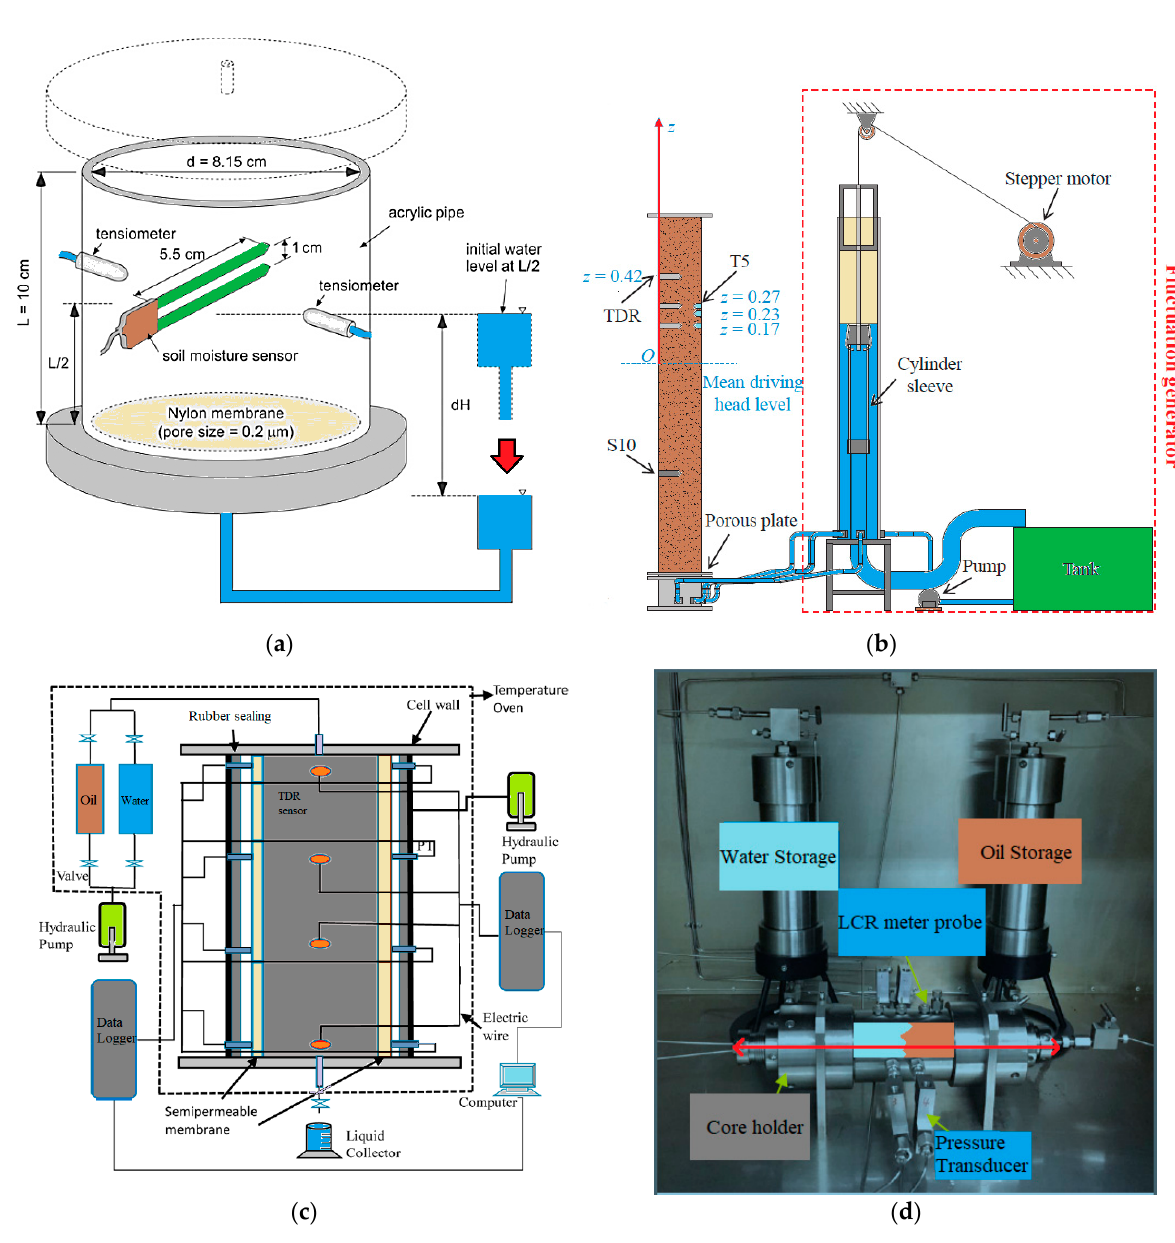
Figure 9. The instrumented soil column and core flooding tests for investigating dynamic nonequi- librium effects for transient two-phase flow in porous media: ( a ) short soil column [30]; ( b ) large soil column [161]; ( c ) core flooding test illustration [162]; ( d ) core flooding test picture [163].